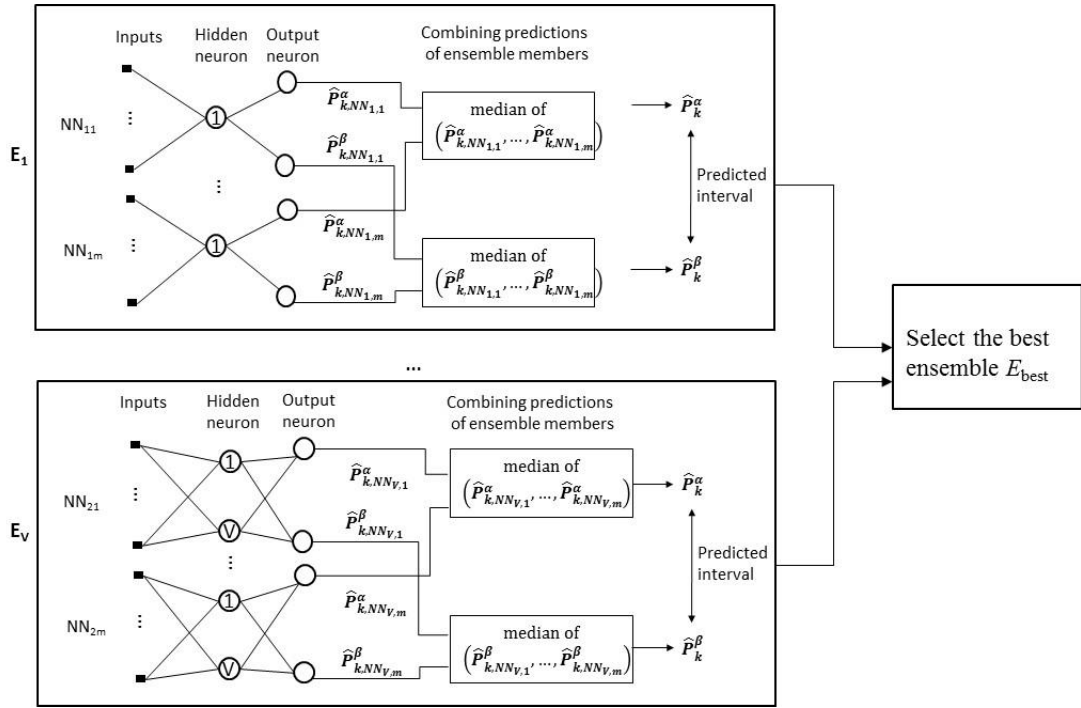
Figure 6. Ensemble construction and selection for NNE2D.